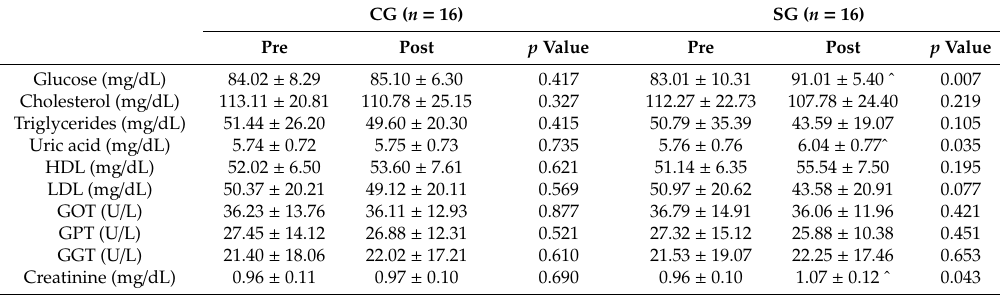
Table 8. Biochemical values of both groups.